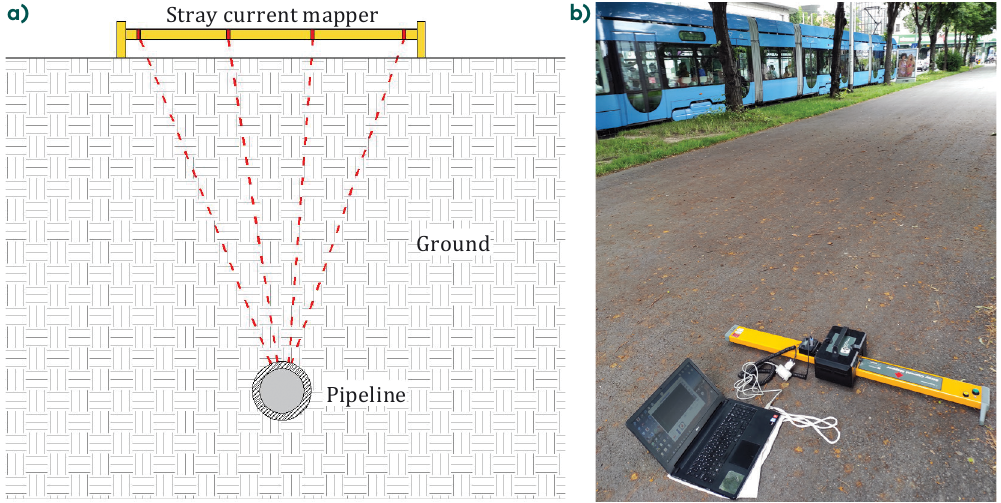
Figure 5. a) Schematic representation of the measurements with the SCM device, b) Stray current sensor bar during the measurement,